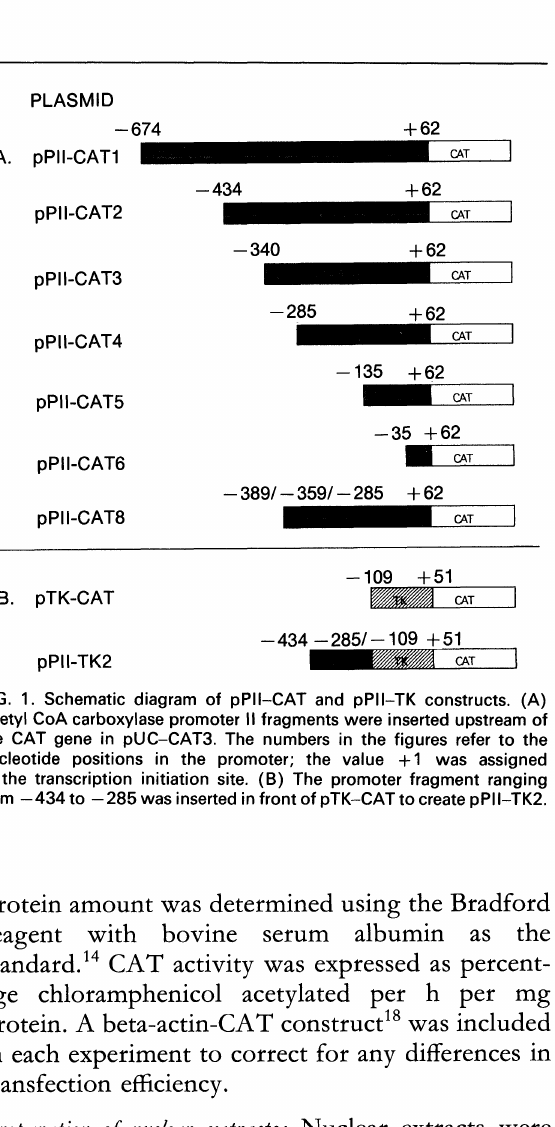
Protein amount was determined using the Bradford reagent bovine serum